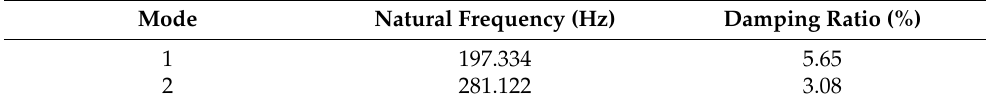
Figure 2. Experimental equipment and measuring equipment. Table 3. Modal parameters of carbide cutting tools.